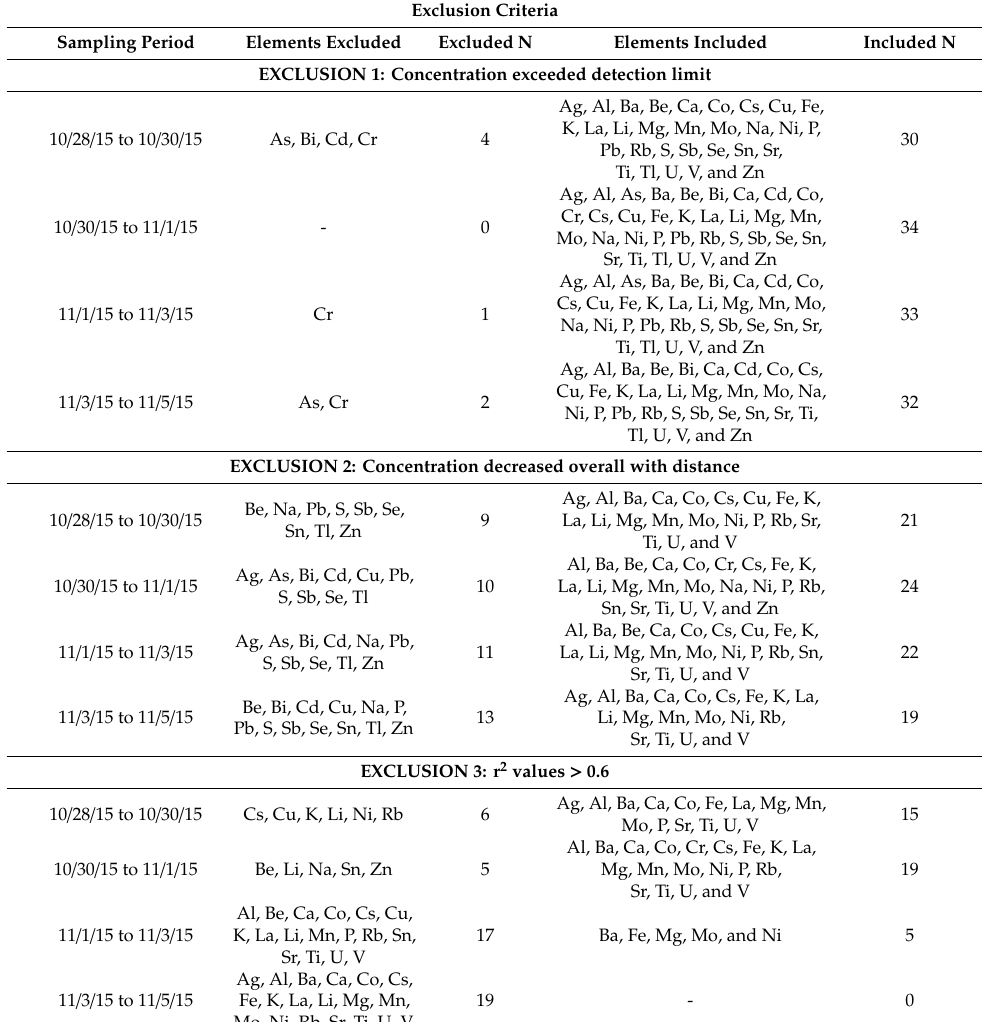
Table 1. Selection criteria for elements per sample period 1